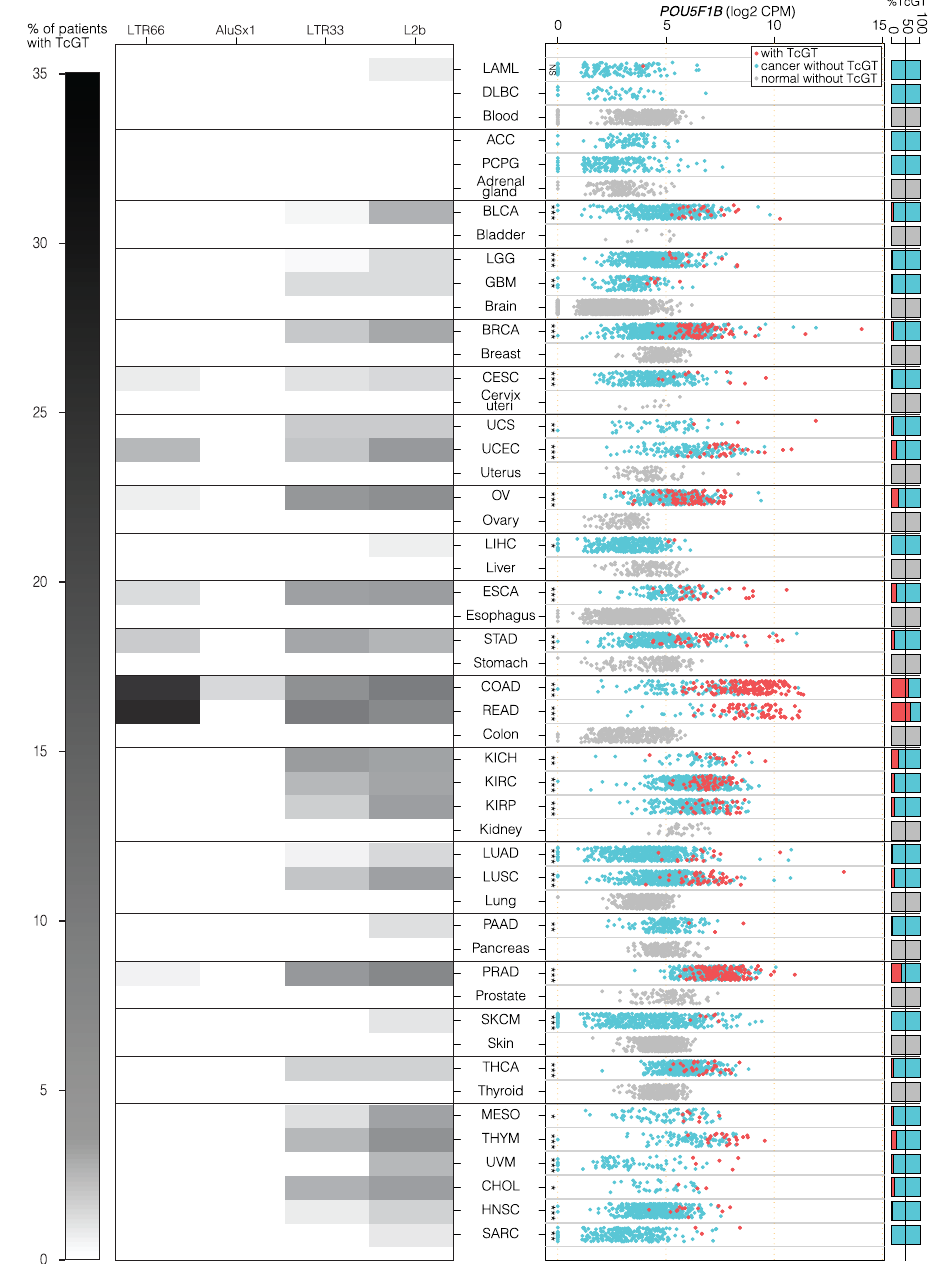
Fig. 6 | POU5F1B-encoding TcGTs are detected in several other cancers. a Left, heatmap depicting the percentage of patients with POU5F1B TcGTs for indicated TCGA cancers and normal tissues of the Genotype – Tissue Expression (GTEx) dataset 47 . Locations of TEs acting as TSS are indicated on top, with the intensity of grayshadeproportionaltousagefrequency.Right,levelsofexpressionofPOU5F1B transcripts in 9,566 samples from 32 cancer types of the TCGA dataset and in 8878samplesfrom29normaltissue typesoftheGTExdataset.ForeachTCGAand GTEX category, expression of TcGT samples was compared to non-TcGT samples with a two-sided t -test. Signi fi cance levels are shown as stars (*** pval <0.001, ** pval <0.01, * pval <0.05). Right margin, percentage of samples with (red) or without TcGT (blue -cancer-, gray -normal tissue – ). Abbreviations: ACC adreno- cortical carcinoma; BLCA bladder urothelial carcinoma; BRCA breast carcinoma;